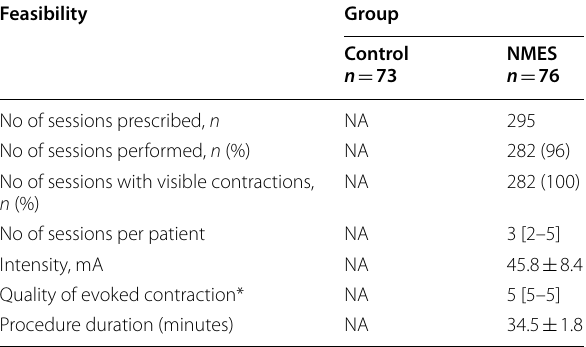
Table 3 NMES protocol feasibility